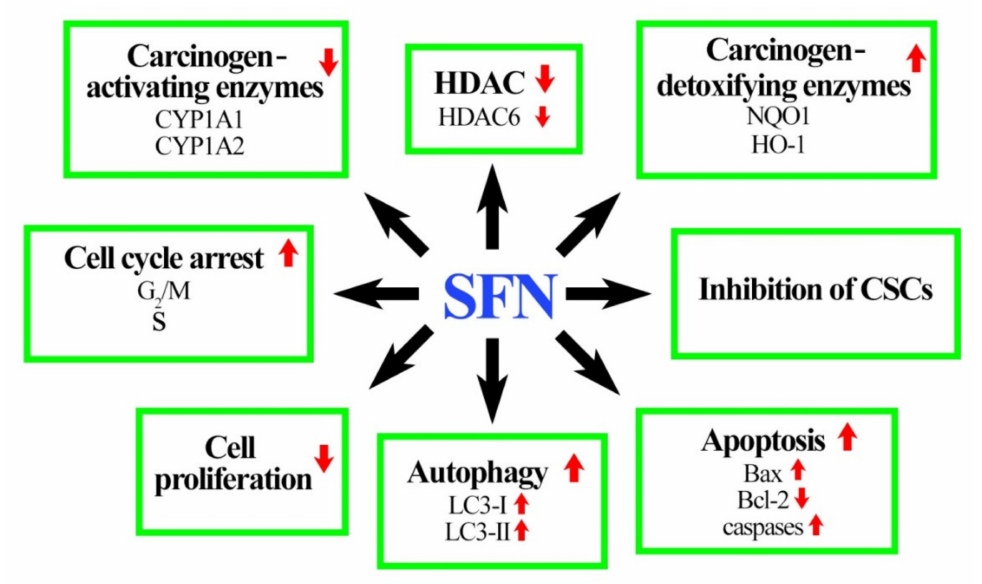
Figure 2. Mechanisms of SFN activity in breast cancer tissue.